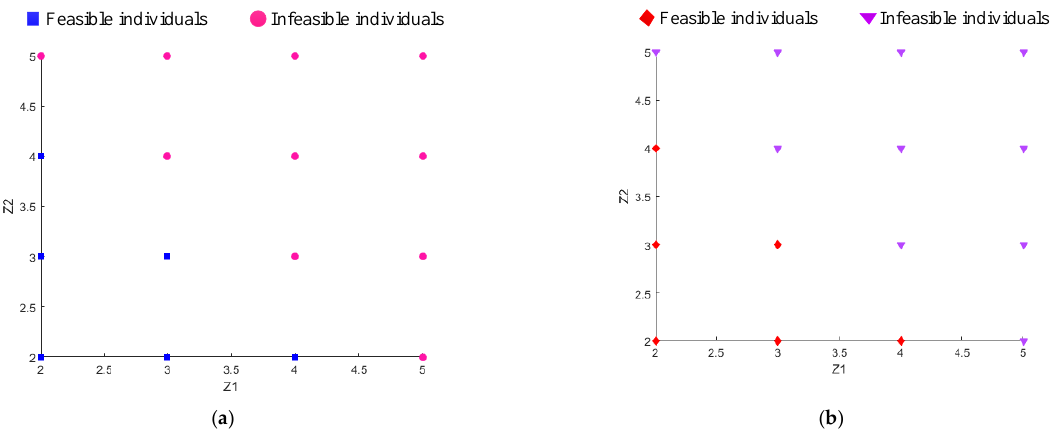
Figure 9. Separation of feasible/infeasible solutions. ( a ) Feasible/infeasible individuals obtained by SVM; ( b ) Feasible/infeasible individuals obtained by constraint function. SVM; ( b ) Feasible/infeasible individuals obtained by constraint